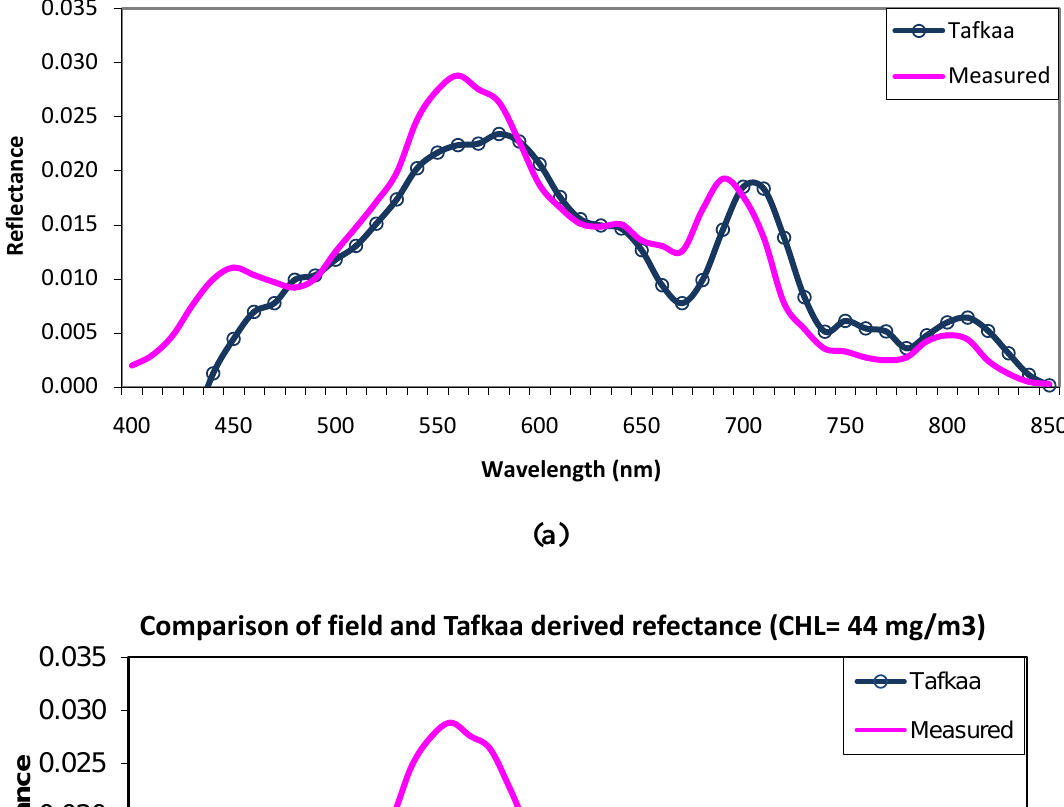
Figure 3. Comparisons of measured spectra for station 2 (a) and station 3 (b) with different chlorophyll concentrations and Tafkaa derived AVIRIS reflectance spectra for the corresponding sampling stations (see Figure 1).